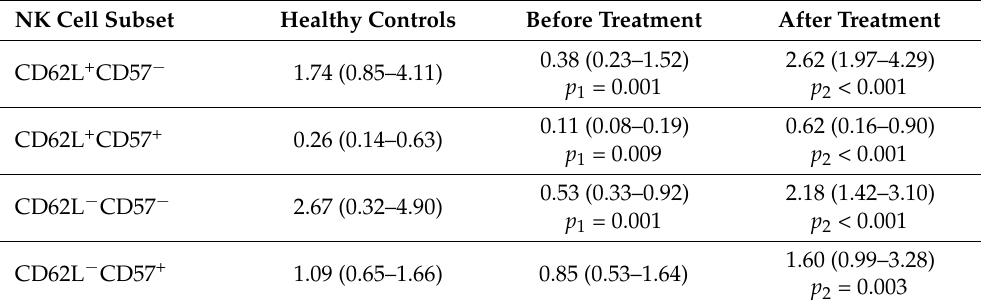
Table 4. CD57 and CD62L co-expressing NK cell subsets (%) in convalescent COVID-19 individuals before and after recombinant human IL-2 treatment (Me